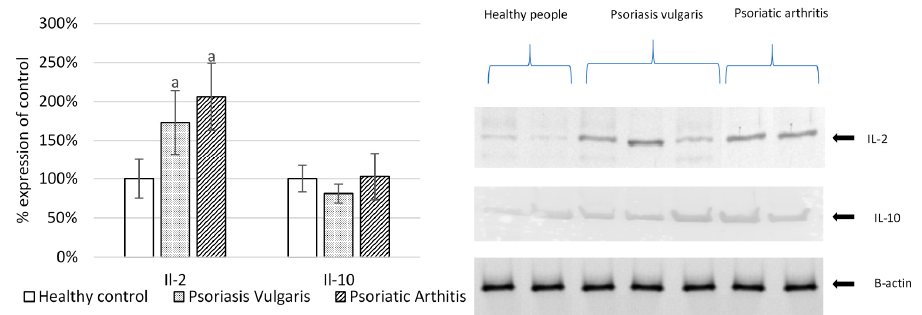
Figure 6. The expression of interleukins and pro-inflammatory mediators in mononuclear cells from patients with psoriasis vulgaris (n = 16), psoriatic arthritis (n = 8), and healthy subjects (n = 8). IL-interleukine. Data points represent the mean ± SD; a, significantly different from healthy subjects, p < 0.05 .